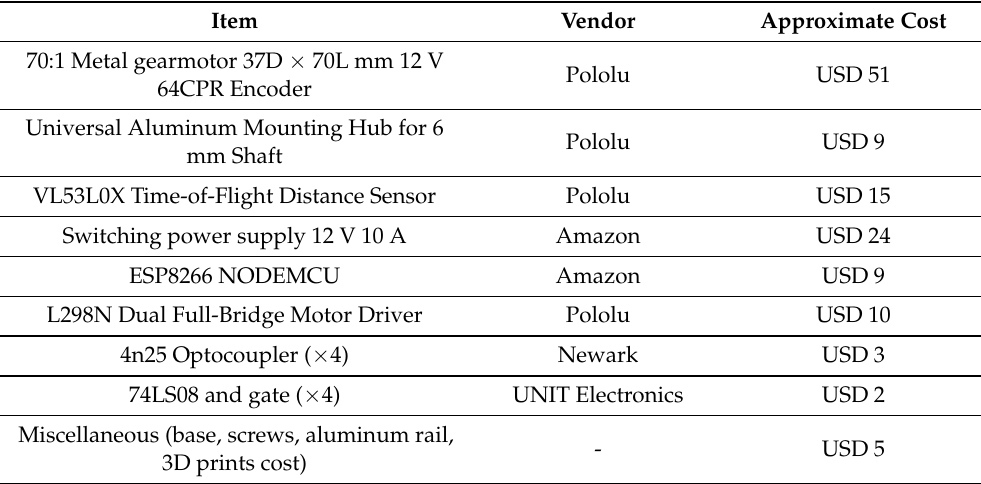
Table 2. List of